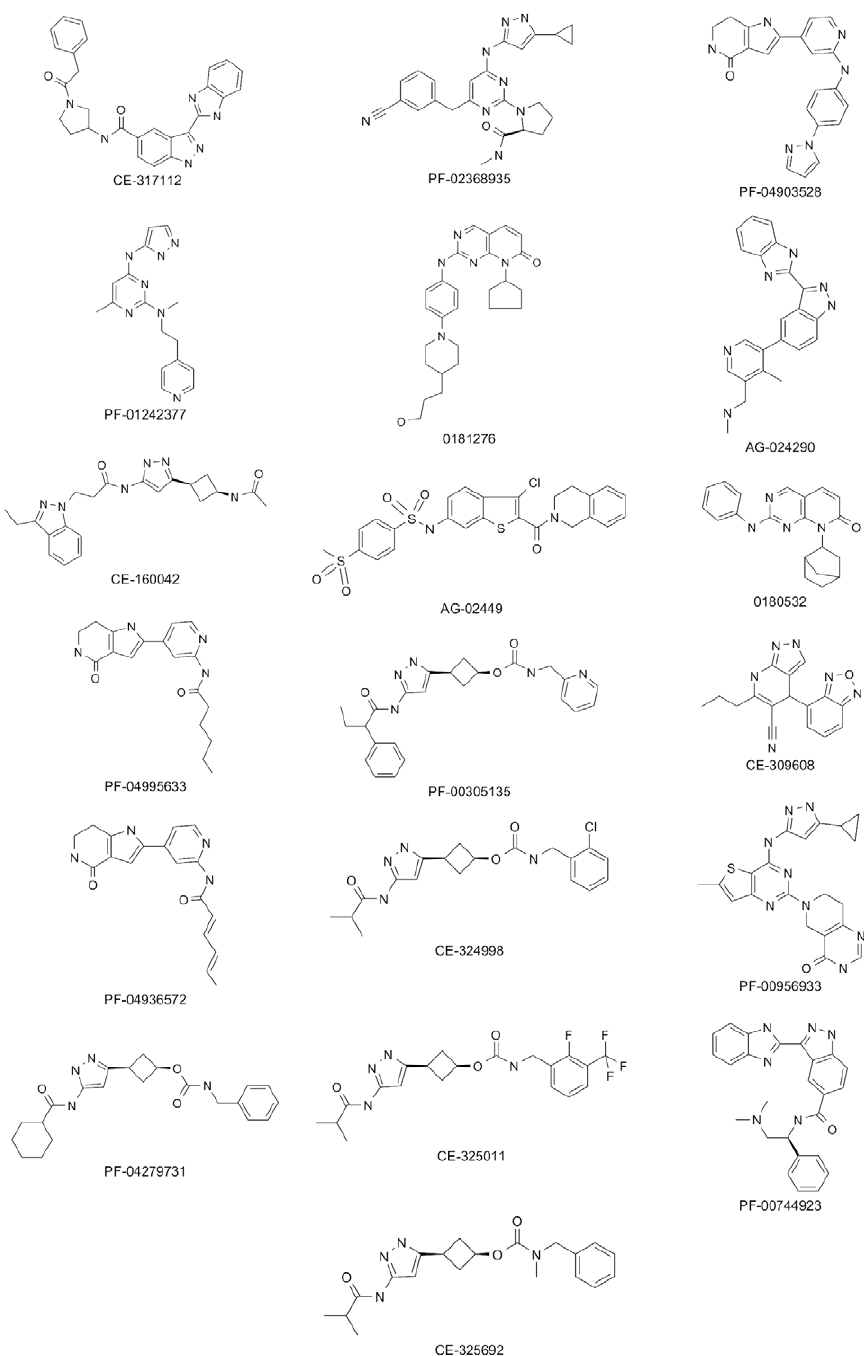
Figure 2. Chemical structures of the inhibitors.